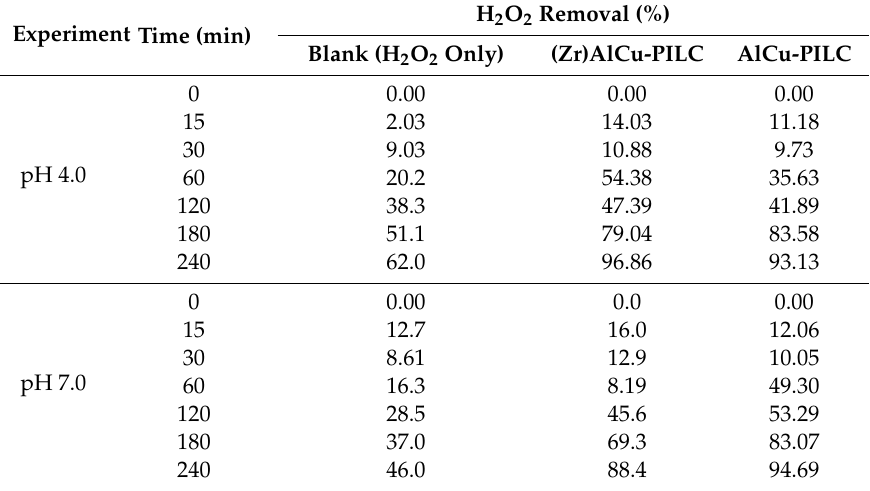
Table 5. H 2 O 2 removal in the photocatalytic experiments using di ff erent catalysts. General conditions: pH 4.0 and pH 7.0, catalyst dosage = 3.00 g / L, [ TOC ] 0 = 500 mg C / L, UV-C